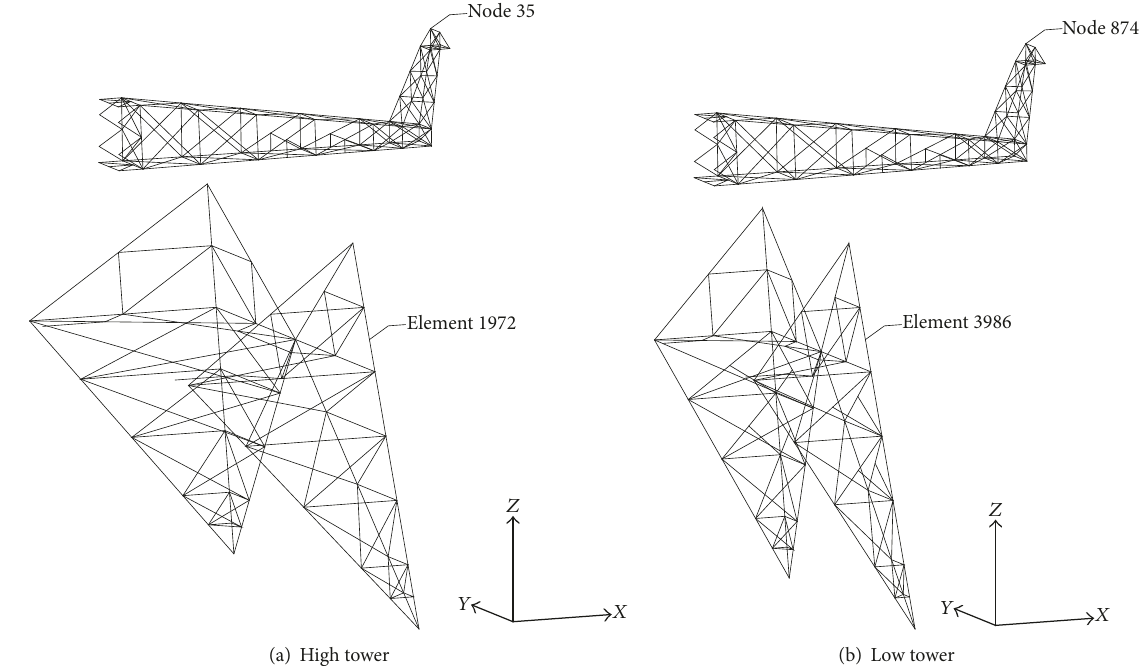
Figure 6: The location map of the maximum displacement nodes and the maximum axial force elements.